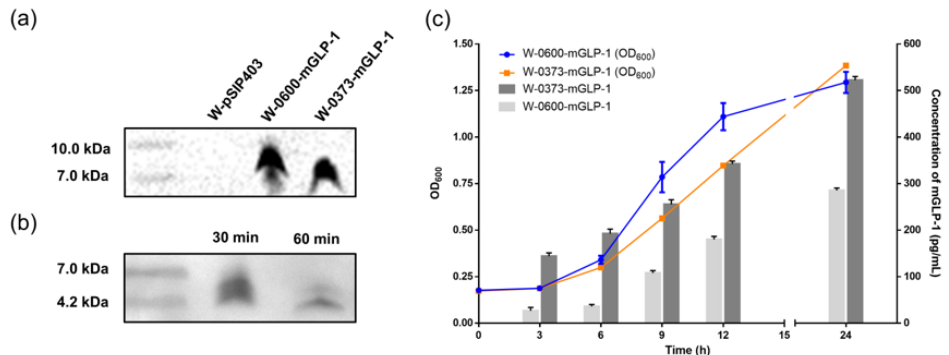
Figure 2. Western blotting and enzyme-linked immunosorbent assay (ELISA) analysis. Anti-His-tag antibody was used to detect mGLP-1 in supernatant. ( a ) The culture supernatant concentrated 50-fold of W-pSIP403 and W-SP-mGLP-1; ( b ) The supernatant of W-0373-mGLP-1 treated with 1 mL trypsin for 30 and 60 min; ( c ) The growth curves and ELISA of transformed strains at different time points. All data are represented as mean ± standard deviation (SD). OD: optical density.